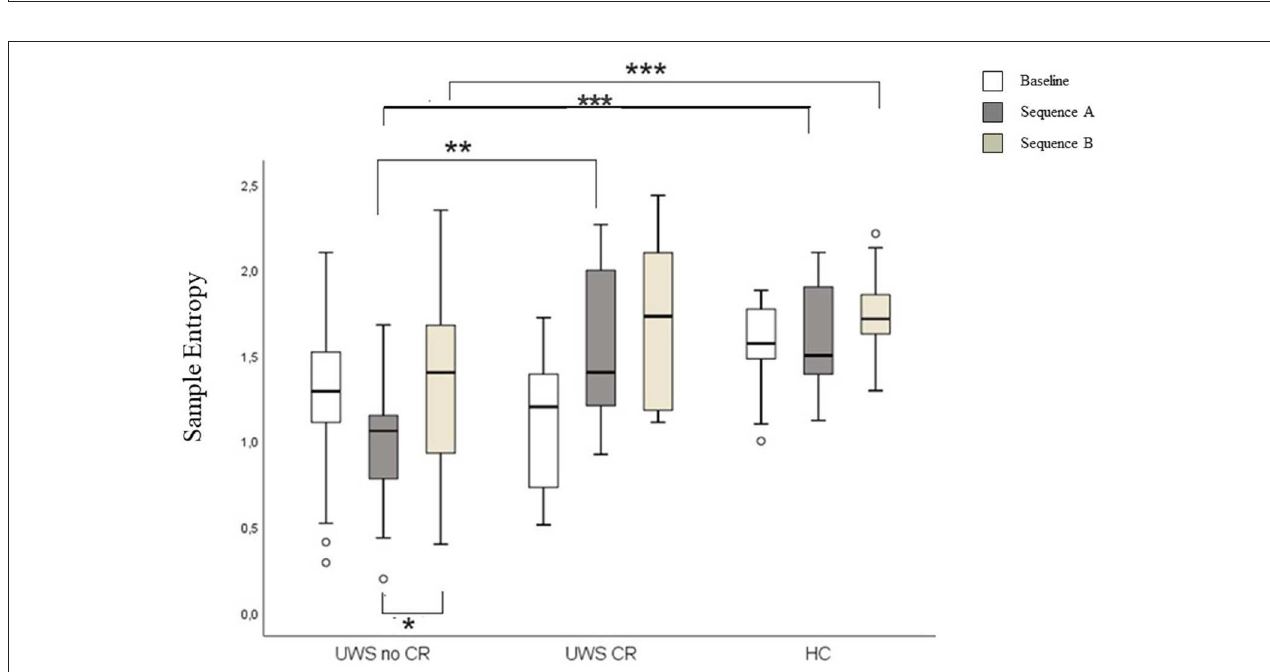
FIGURE 7 | Boxplot of the SampEn. In the figure: baseline (white), sequence A (dark gray) and sequence B (light gray). Significant statistical difference: * p [0.003–0.005]; ** p [0.001]; *** p < 0.0001. = = (Riganello, 2016) in which neural structures are involved in cognitive, affective, and autonomic regulations] modulates a different response to the noxious stimulus, among HC, MCS, and UWS patients. The clear decreasing modulation in UWS patients supported the idea of a correlation with the reduced level of consciousness (Riganello et al.,